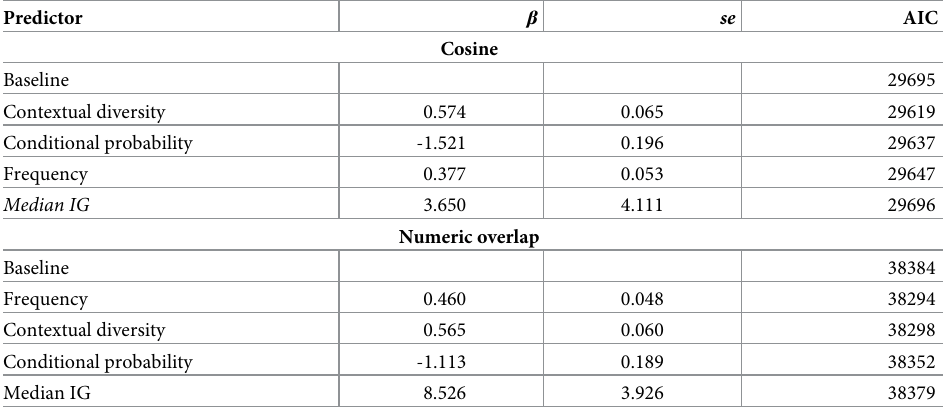
Individual effects of the significant distributional predictors of interest for cosine -based and numeric overlap -based categorization after excluding all function words from the data set. Predictors are ordered according to the reduction in AIC over the baseline model and non-significant predictors are italicized.